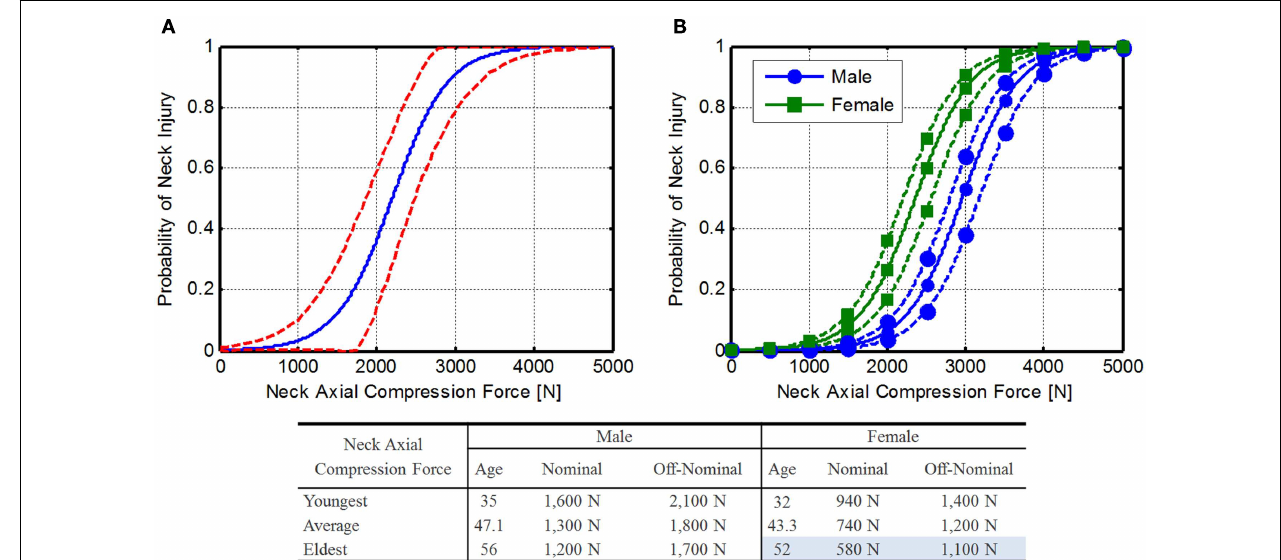
FIGURE 5 | Neck axial compression force injury risk function . (A) Original Pintar risk function (Pintar et al., 1998a) with confidence limits (dashed lines) and (B) expanded risk functions for male and female astronauts. Solid line represents mean astronaut age (47.1 and 43.3 for males and females, respectively), dashed lines represent the youngest and oldest astronauts (male: 35 and 56; female: 32 and 54). Note that force tolerance declines with